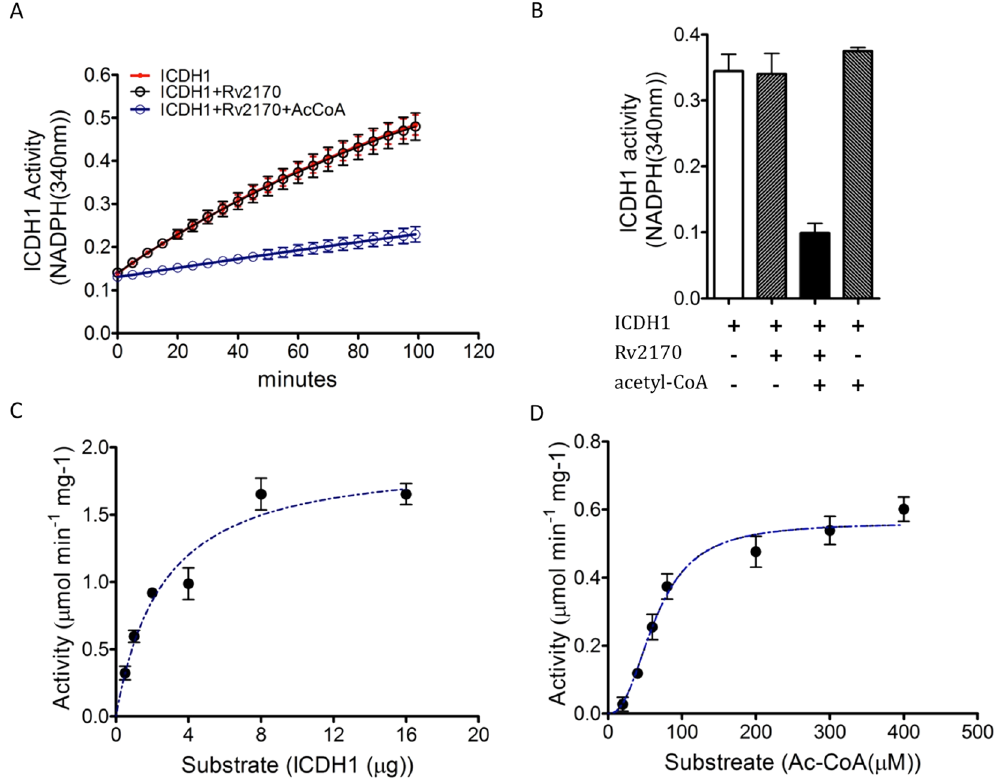
Figure 6. ICDH1 activity is repressed through acetylation by Rv2170. ( A and B ) ICHD1 activity was measured by quantifying NADPH generation during incubation in the presence or absence of Rv2170 and acetyl- CoA. ICDH1 activity was inhibited by Rv2170 only in the presence of acetyl-CoA. ( C and D ) Graphs show substrate saturation curves for lysine acetylation by Rv2170 ( C ) as the ICDH1 substrate is varied at a saturating concentration of acetyl-CoA(200 μ M) or ( D ) as the acetyl-CoA substrate is varied at a saturating concentration of ICDH1 (10 μ g) Error bars show standard deviations from three representative triplicate.